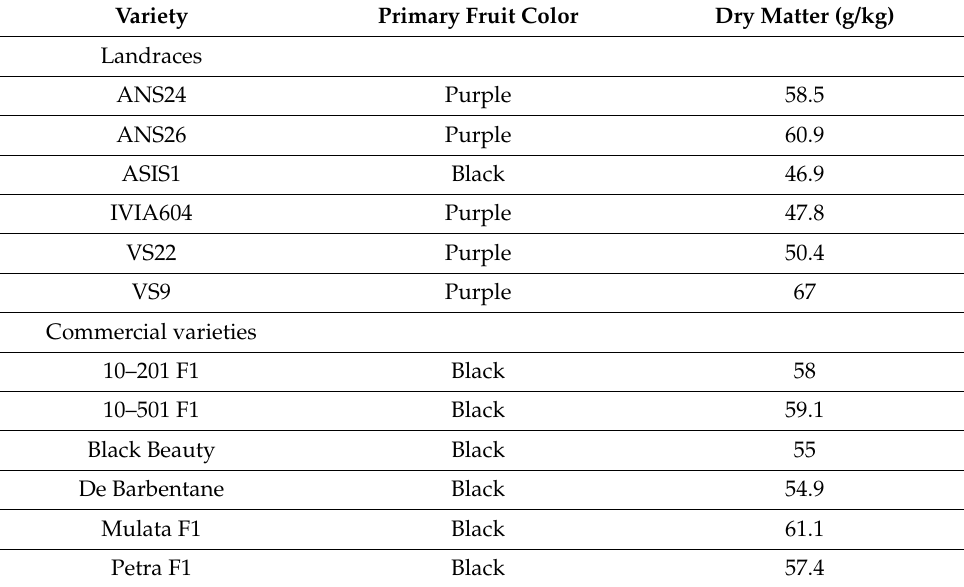
Table 11. Variation in dry matter content in g/kg for different eggplant cultivars